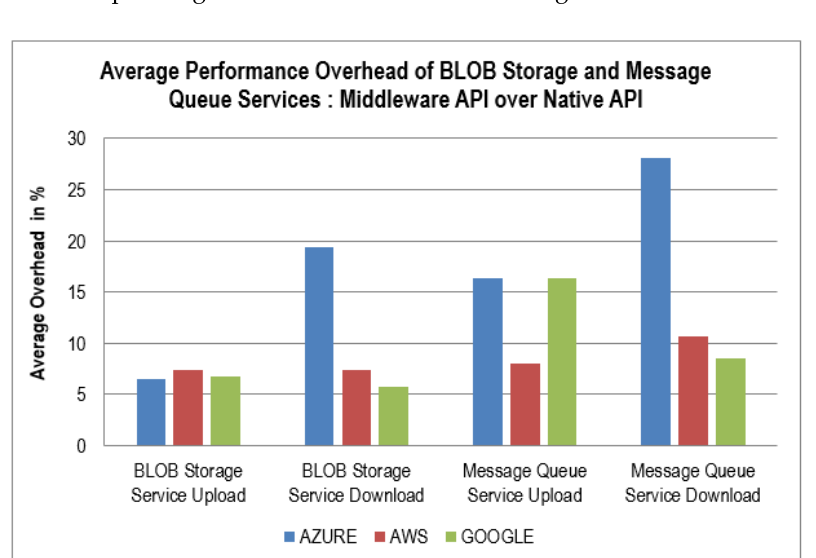
Figure 3. Performance overhead of BLOB storage service and message queue service.